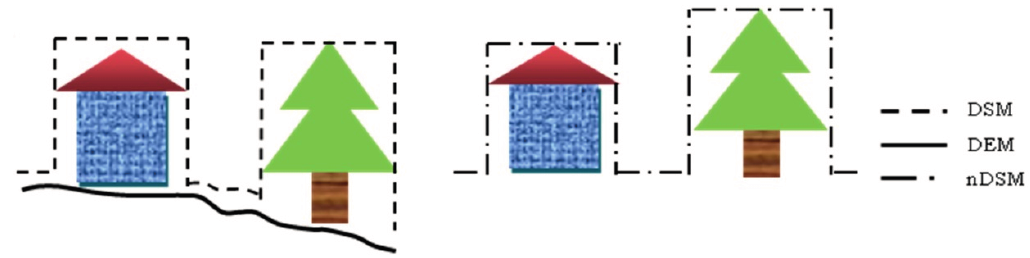
Figure 7. The relationships between the DSM, DEM and